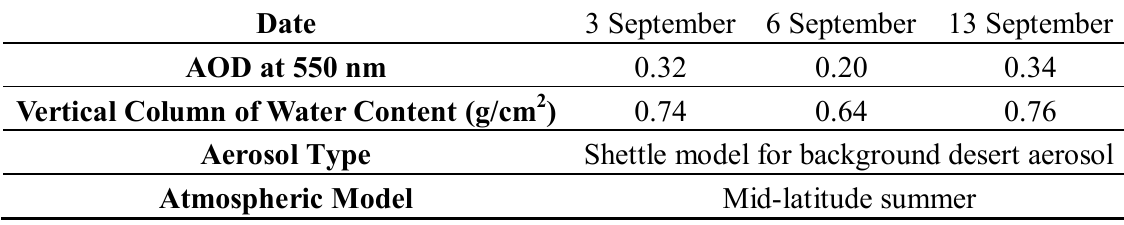
Table 6. Calibration coefficients (W/m 2 /sr/μm/DN) derived from three vicarious calibration methods based on Dunhuang calibration data